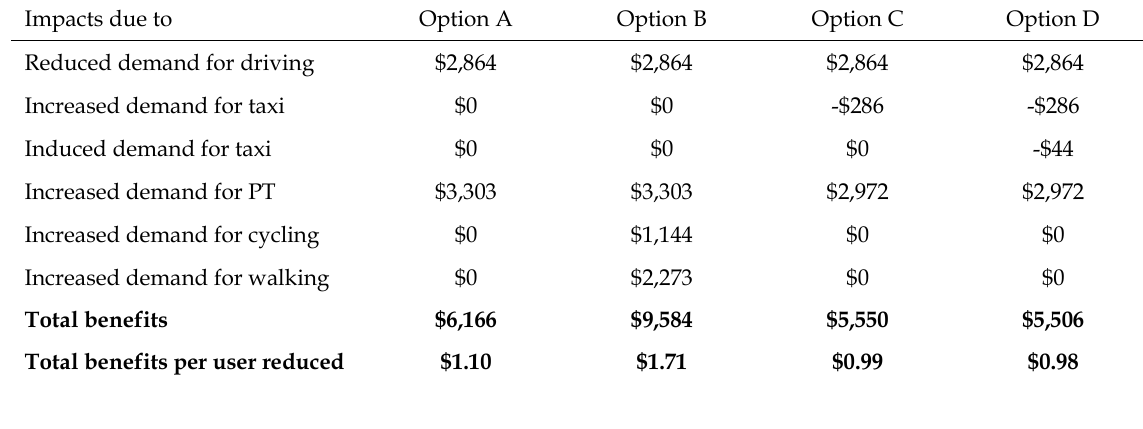
Table 8. Appraisal results (September 2021 dollars, per average